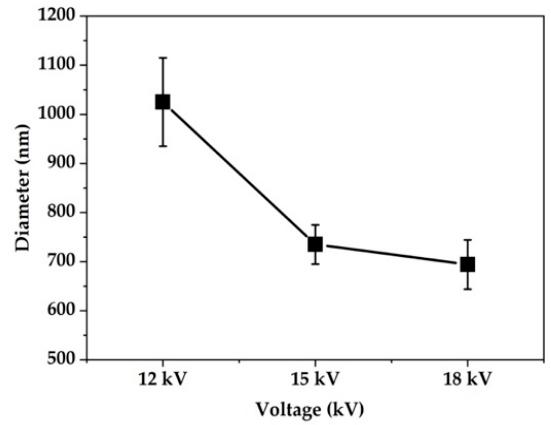
Figure 3. Average diameters of TiO 2 / ZnO nanofibers with voltage.